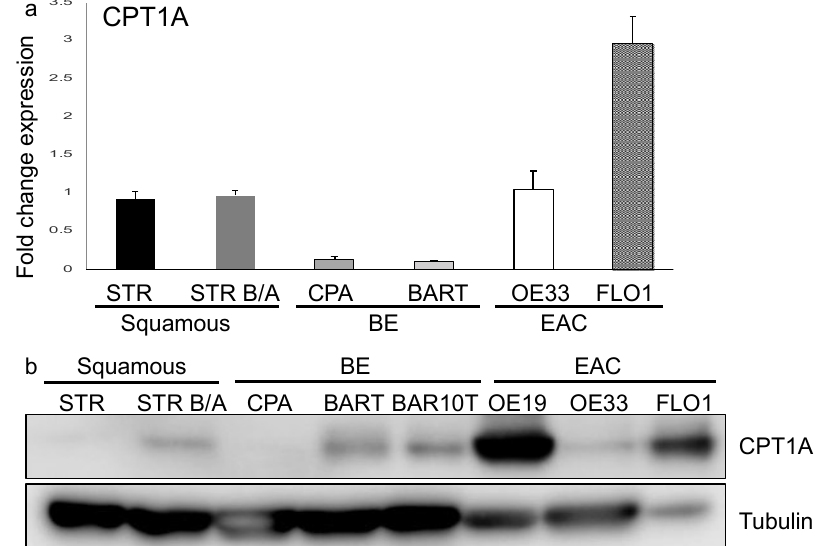
Figure 2. CPT1A is expressed in the esophagus and protein upregulated in the progression to EAC. ( a ) qRT-PCR with primers for CPT1A amplification was performed using RNA extracted from normal immortalized esophageal keratinocytes (STR), bile/acid-tolerant STRs, the Barrett’s esophagus cell lines, CPA and BAR-T, as well as esophageal adenocarcinoma cell lines (OE33 and FLO1) was evaluated. RNA expression is increased in EAC cells. ( b ) Protein was extracted from cell lysates and detected with antibody against CPT1A by Western Blot, showing an increased expression in bile/acid-tolerant STRs, BAR-T and BAR10T as well as EAC cell lines (OE19, OE33 and FLO1) compared to normal.